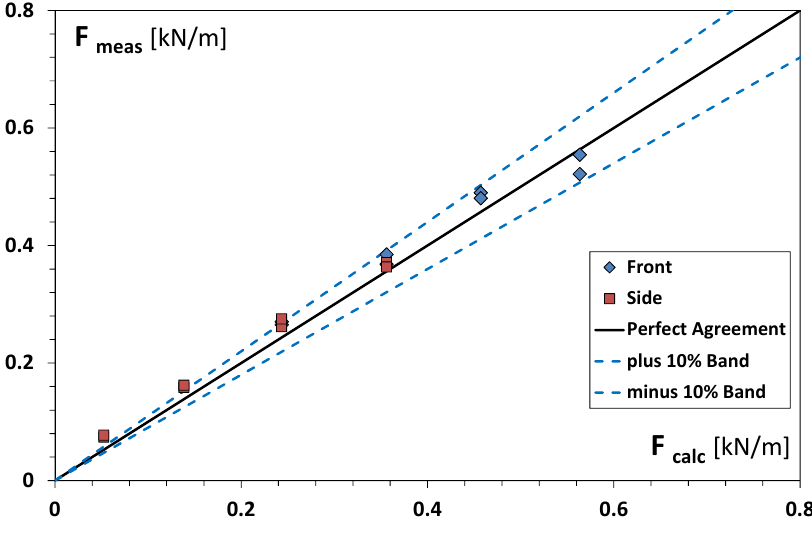
Figure 24. Measured vs. predicted wave forces (short crested